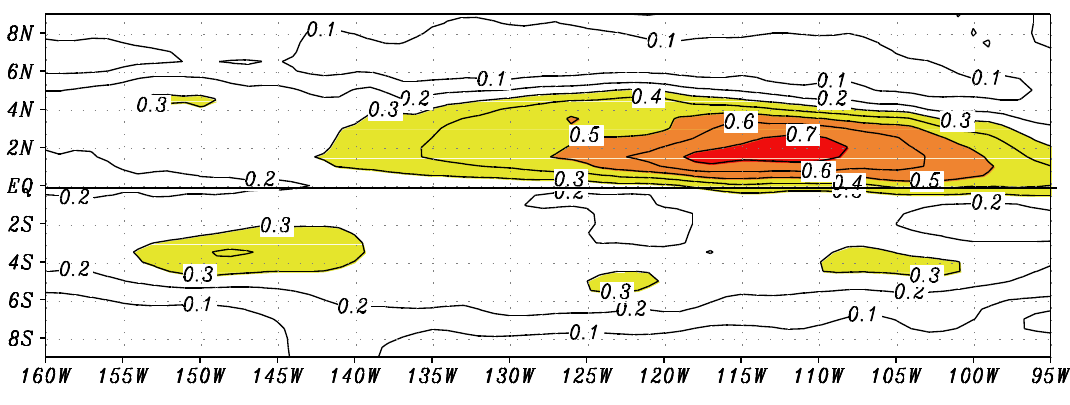
calculated TIW = 3.0 and TIW data in year 13. TIW